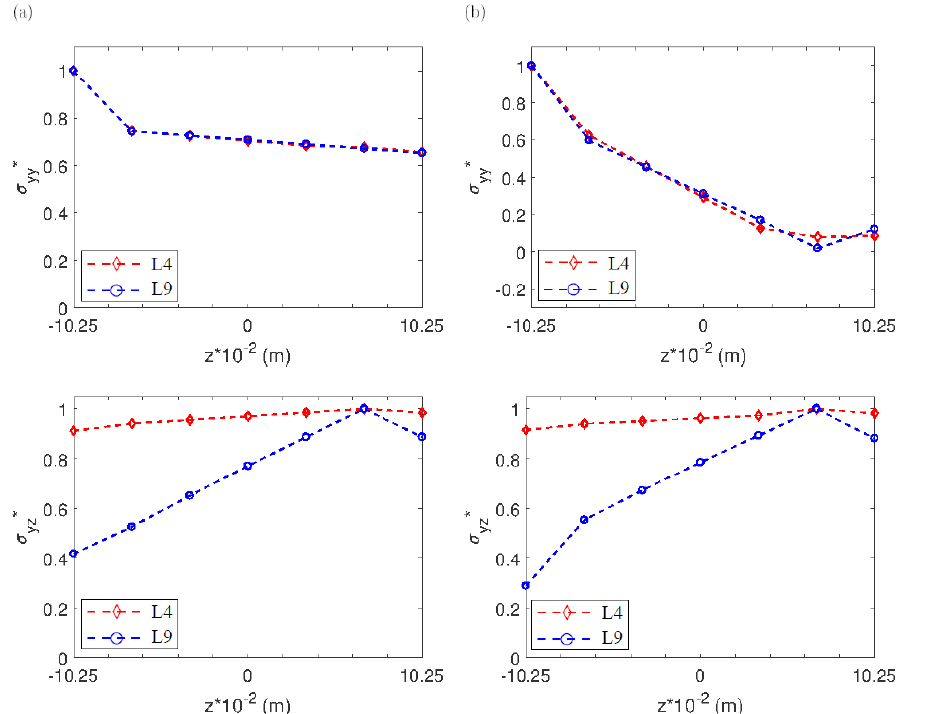
Figure 11. Distribution of axial and shear stress components for ( a ) P ∗ = − 3.3 − 4 and ( b ) P ∗ = − 2.95 − 3 loads in NL regime at L4 and L9 extensions at x = − a 2 /2 and y = L /2 in the single-cell FG beam subject to axial loading for m = 0.5; σ ∗ yy = σ yy / σ yy